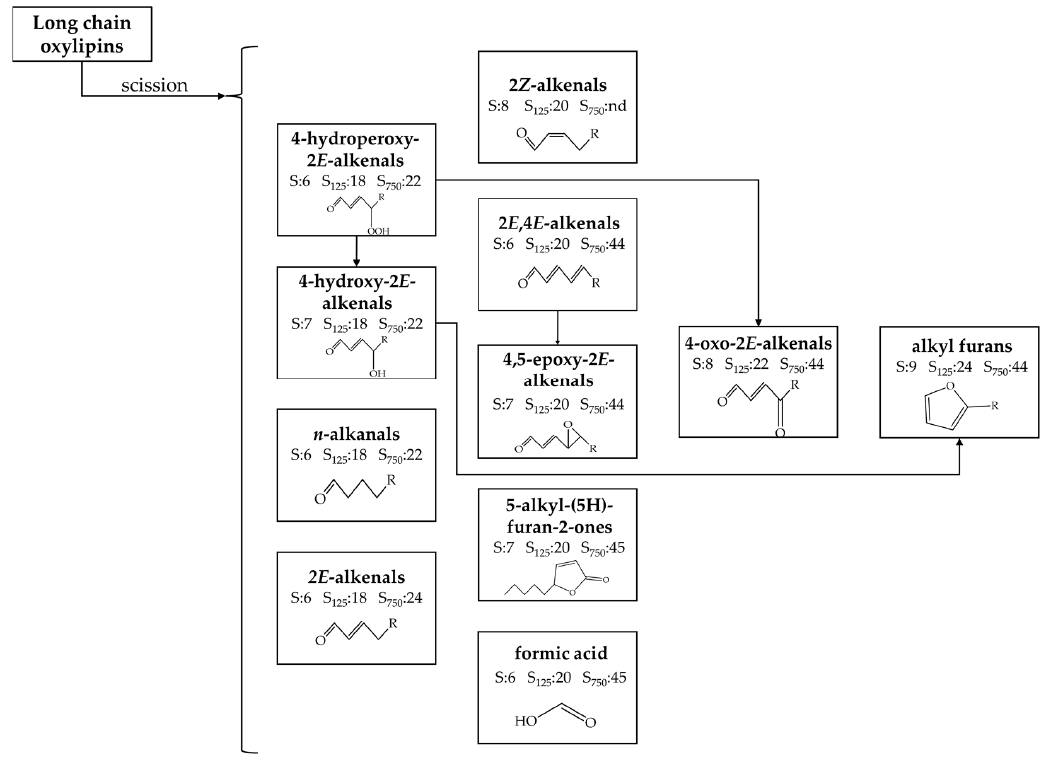
Figure 11. Oxylipins coming from cleavage of long chain oxidation derivatives, with an indication of some of their potential precursors according to certain authors [58,59,68,92–98], ordered from left to right and from top to bottom according to the beginning of their formation in samples S 125 and S 750 respectively after to be submitted to accelerated storage at 70 °C (nd: not detected).